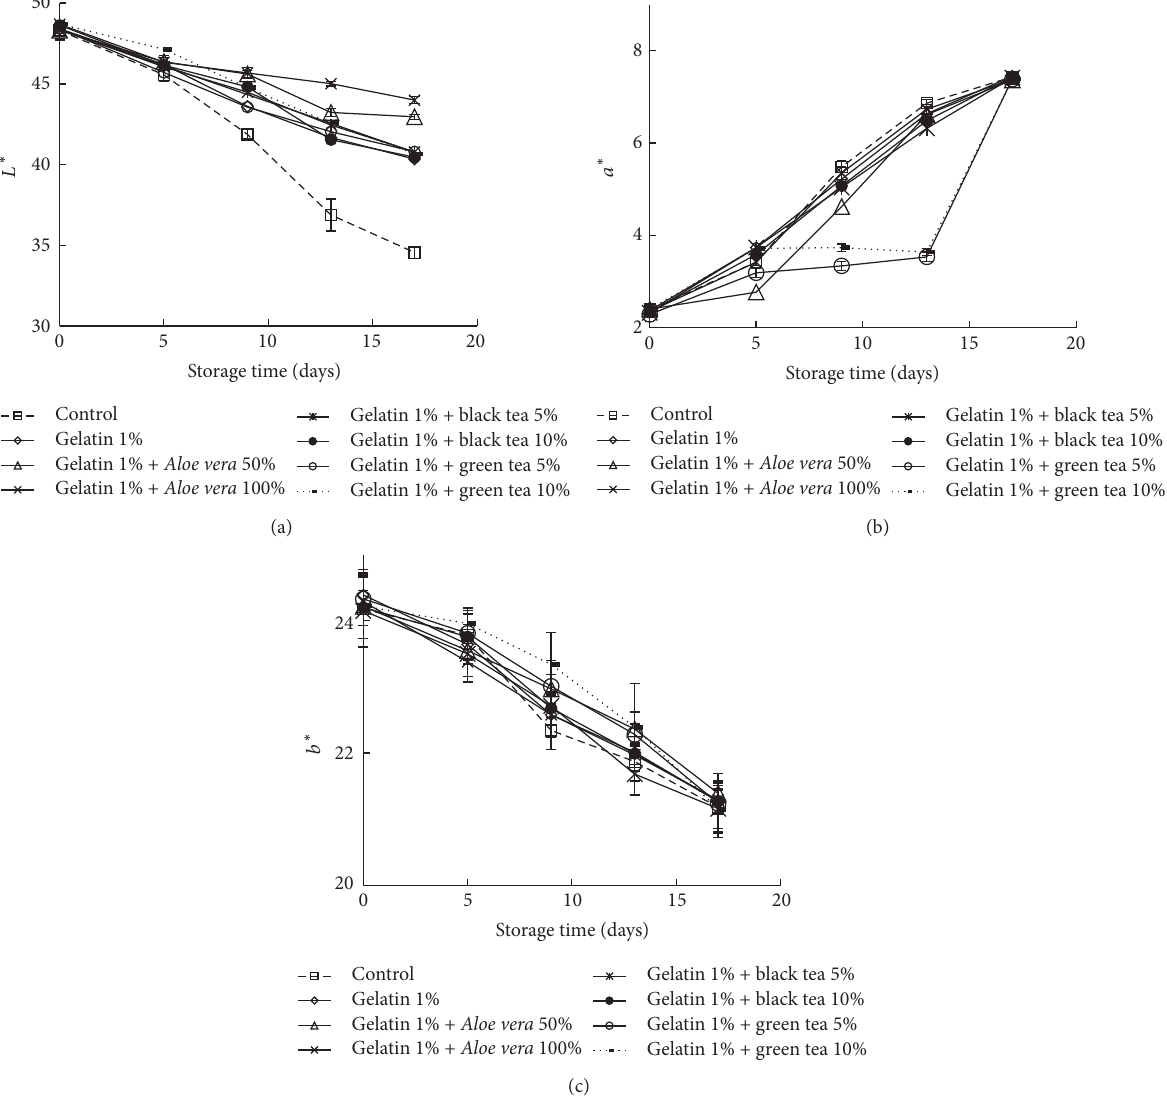
Figure 2: Color parameters ( 𝐿 ∗ , 𝑎 ∗ , and 𝑏 ∗ ) changes of coated fresh-cut oranges during storage at 4 ∘ C for 17 days. Error bars represent standard deviation between replicates ( 𝑛 = 3